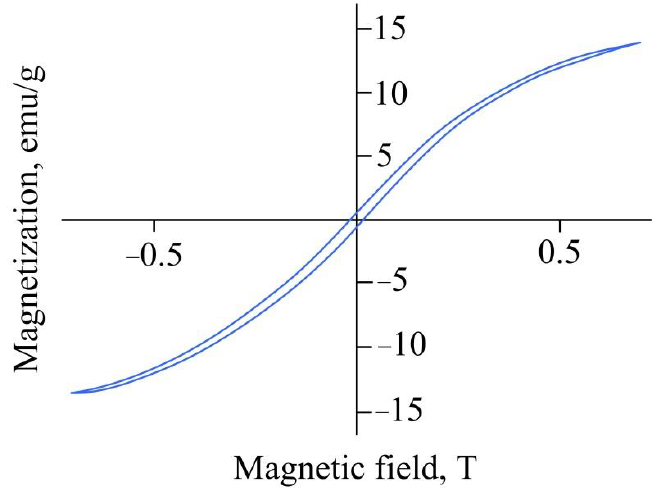
Figure 10. Magnetic properties of the sorbent with iron particles.